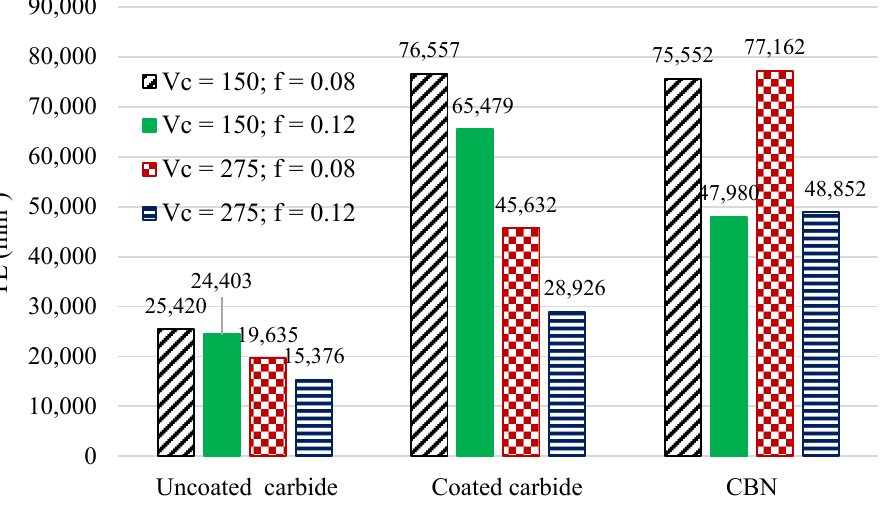
Figure 4. Tool life values for the 12 experimental runs.